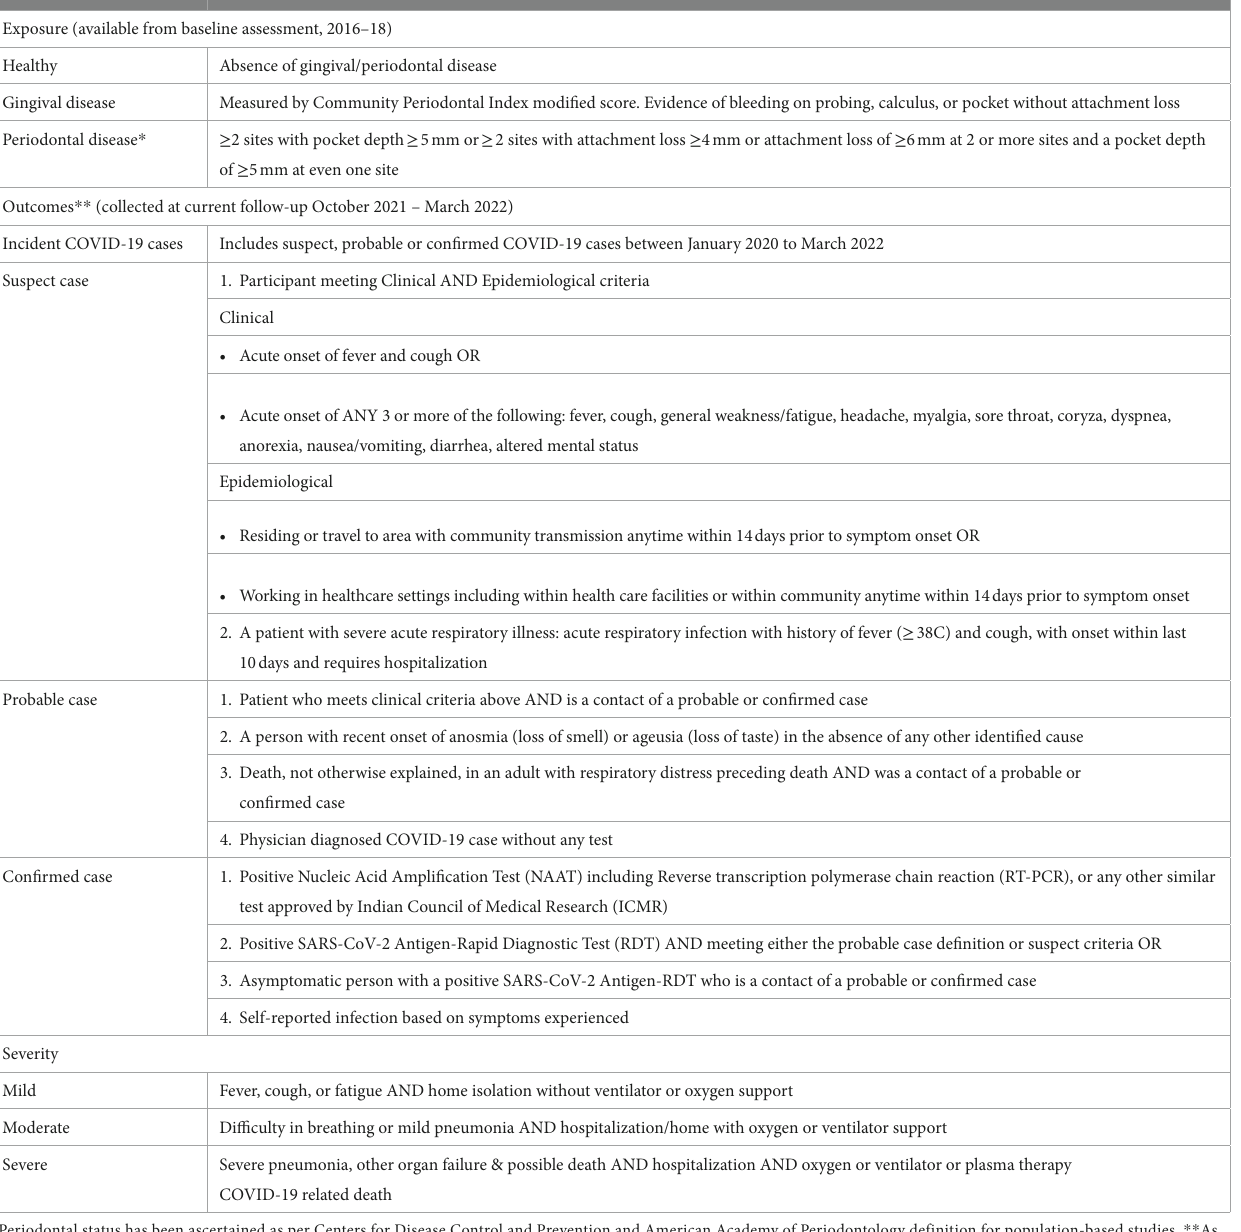
TABLE 1 Exposure and outcome assessment. Variable